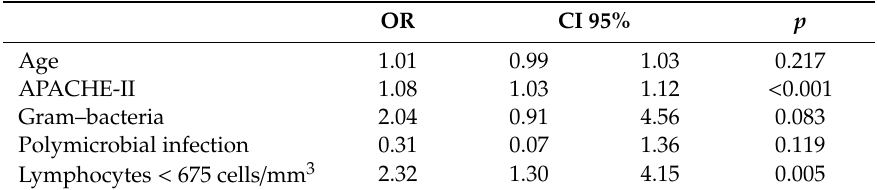
Table 3. Logistic regression analysis for predicting ICU mortality in the sCAP group with septic shock: lymphocyte count.